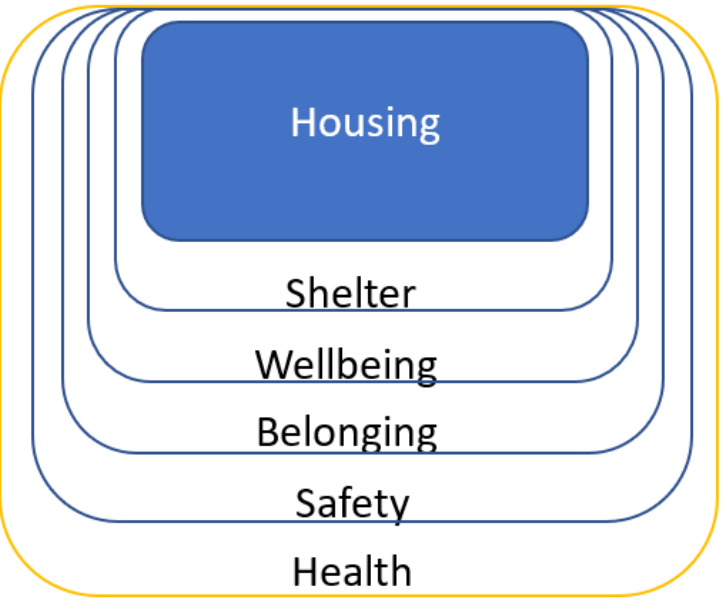
Figure 1. The importance of housing.